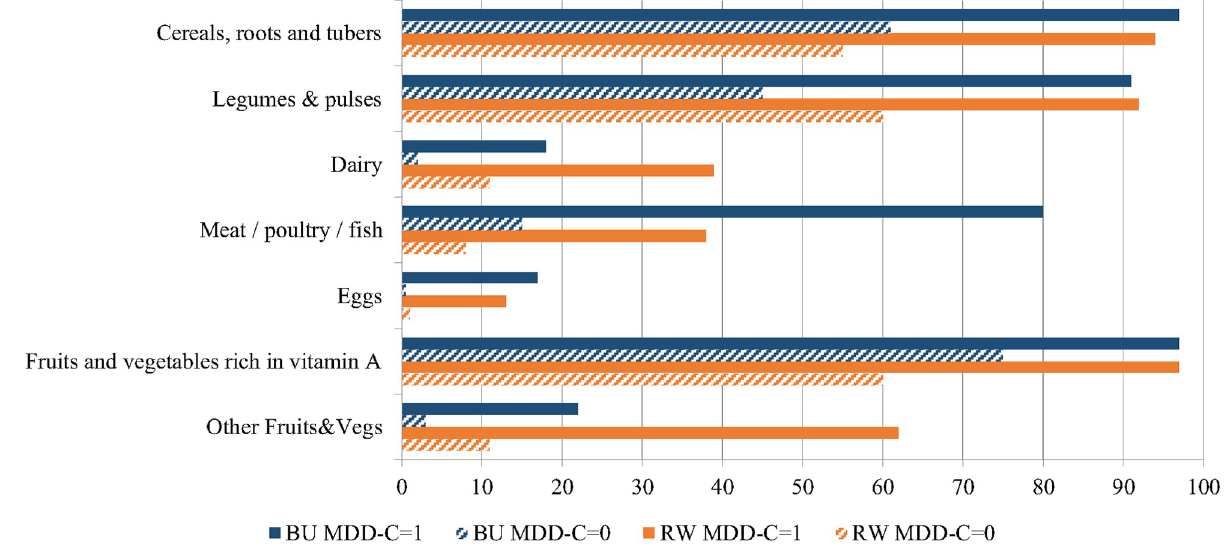
Fig 3. Percentage of children aged 6–23 months who consume each food group by MDD in Burundi and Rwanda, DHS 2010.